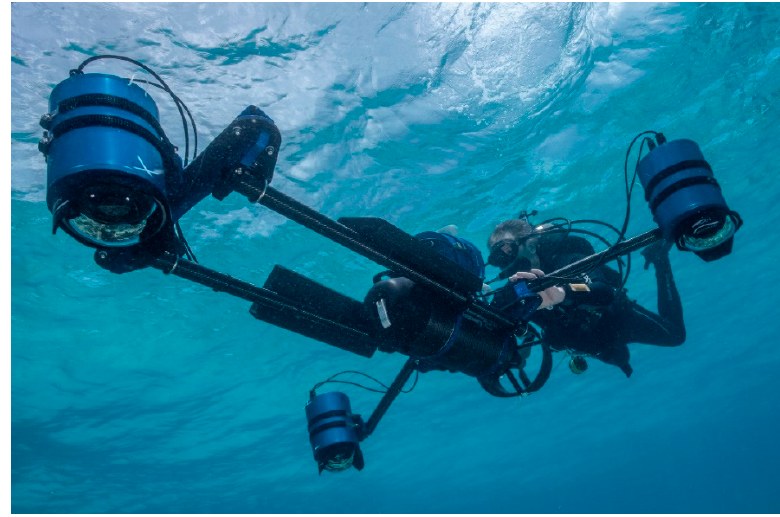
Figure 5. A diver operates SeaArray.